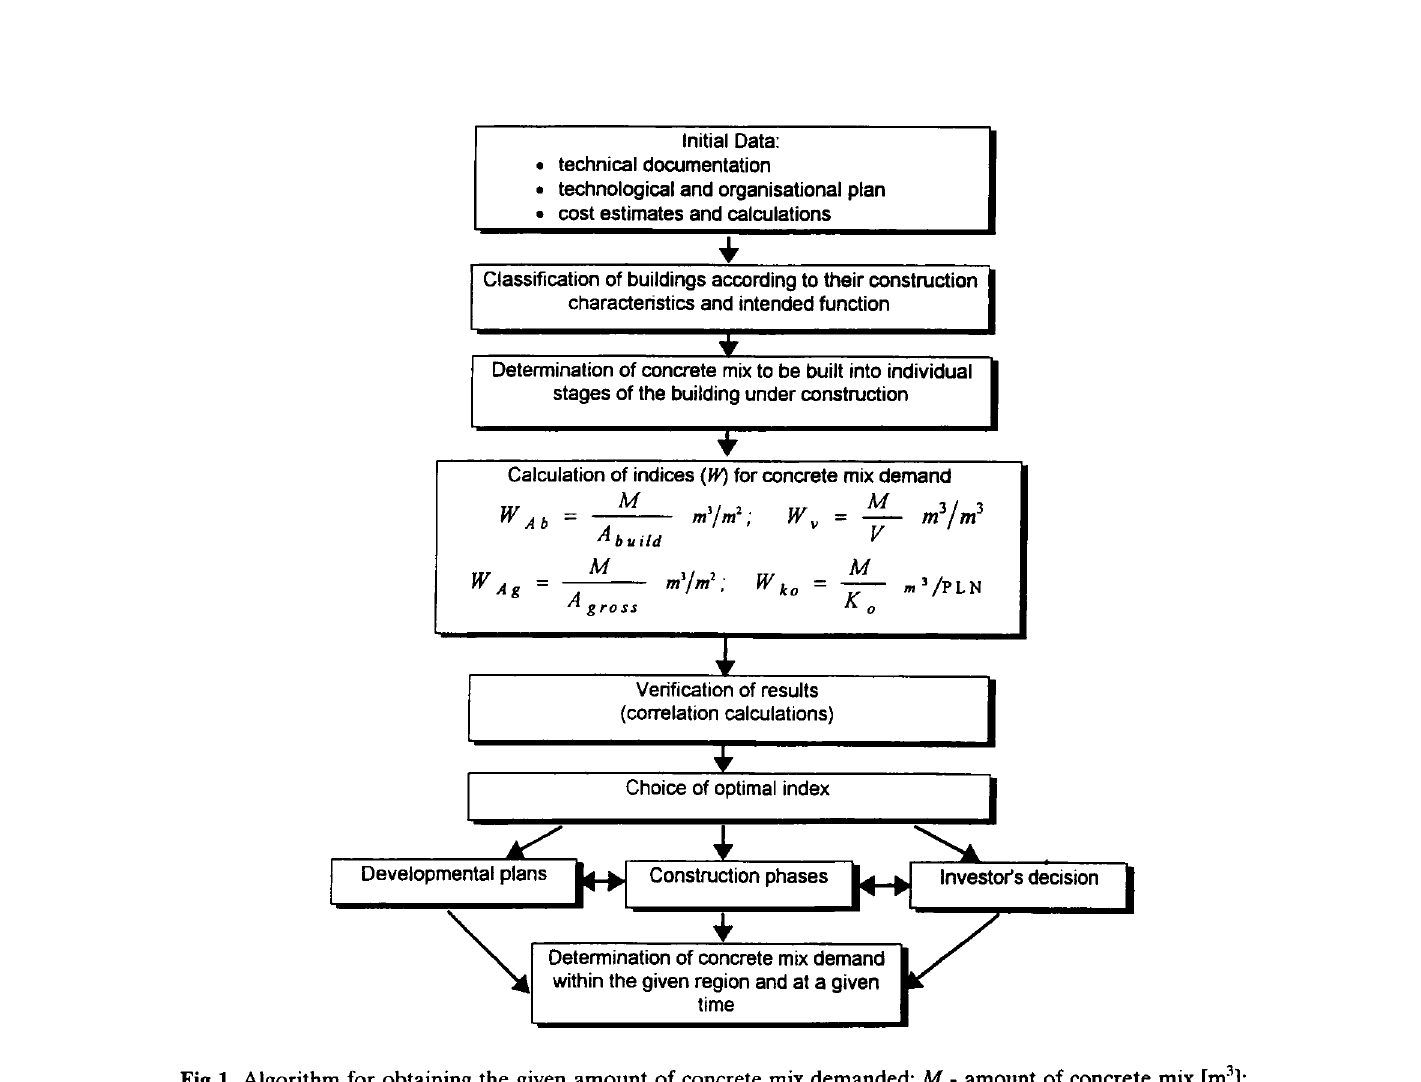
Fig 1. Algorithm for obtaining the given amount of concrete mix demanded: M - amount of concrete mix [m 3 ]; Anuilci- area of building [m 2 ];Agross- gross area [m 2 ]; V- volume of building (m 3 ]; Ko- estimated value